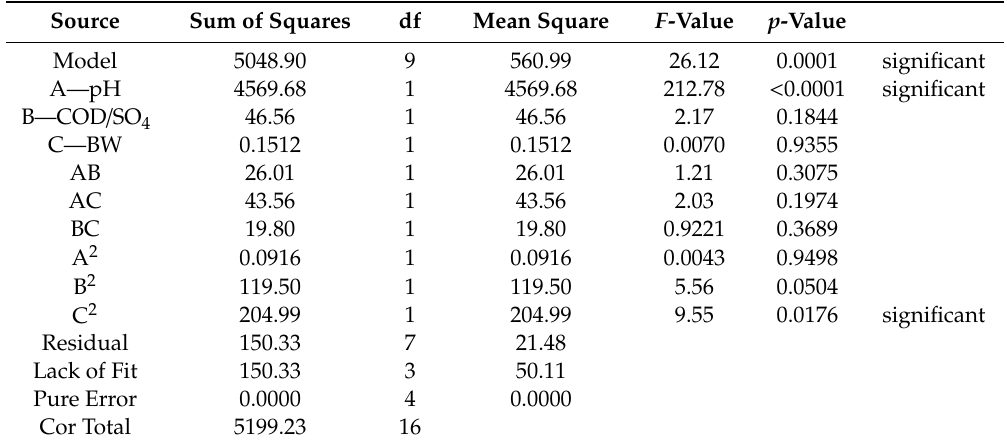
Table 3. ANOVA of the sulphate removal response quadratic